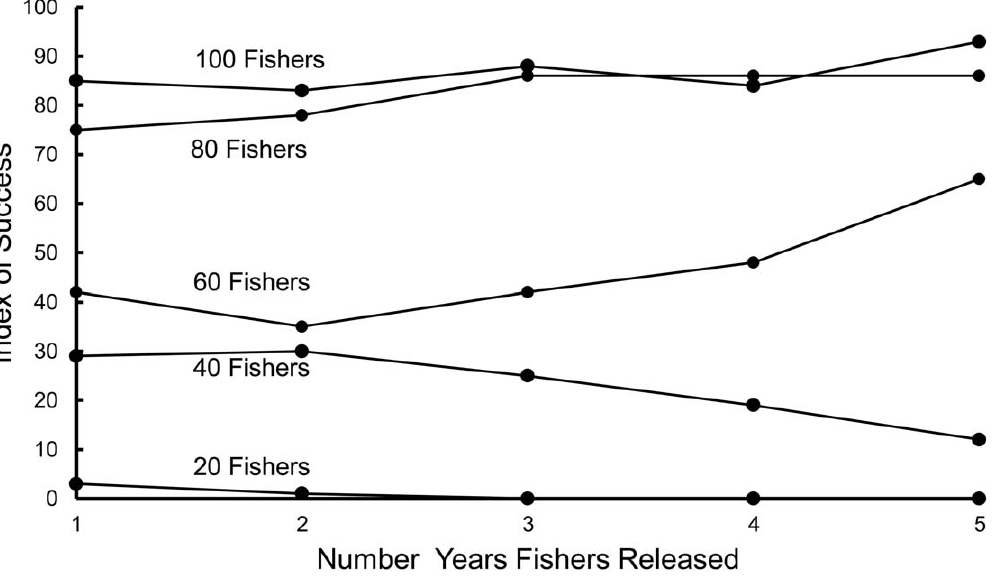
Figure 5. Predicted relationship between the number of years fishers are released and reintroduction success. The index of success was predicted for a fixed number of fishers released all in one year or released over 2, 3, 4 or 5 years (e.g., 60 fishers released in 1 year; 30 in each of 2 years; up to 12 in each of 5 years). Points represent mean values for 100 simulations.